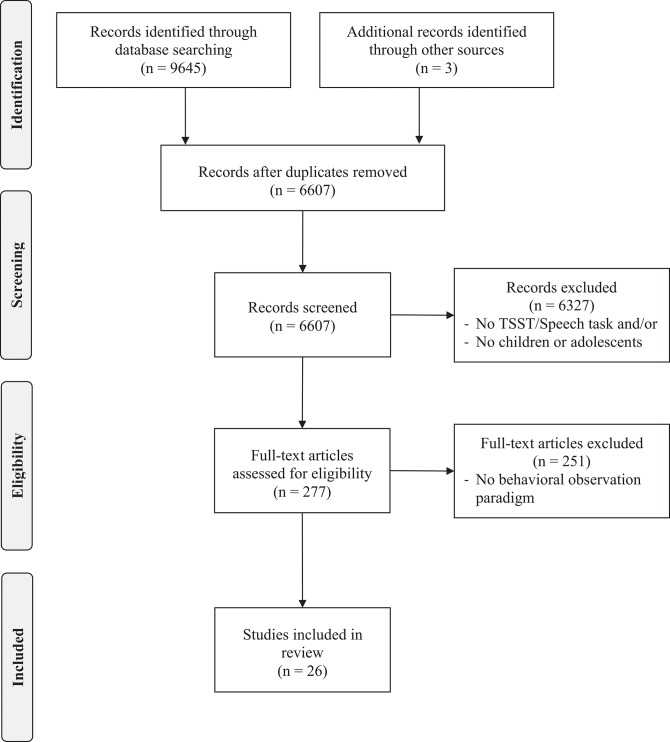
PRISMA flow diagram for the different phases of the systematic review.